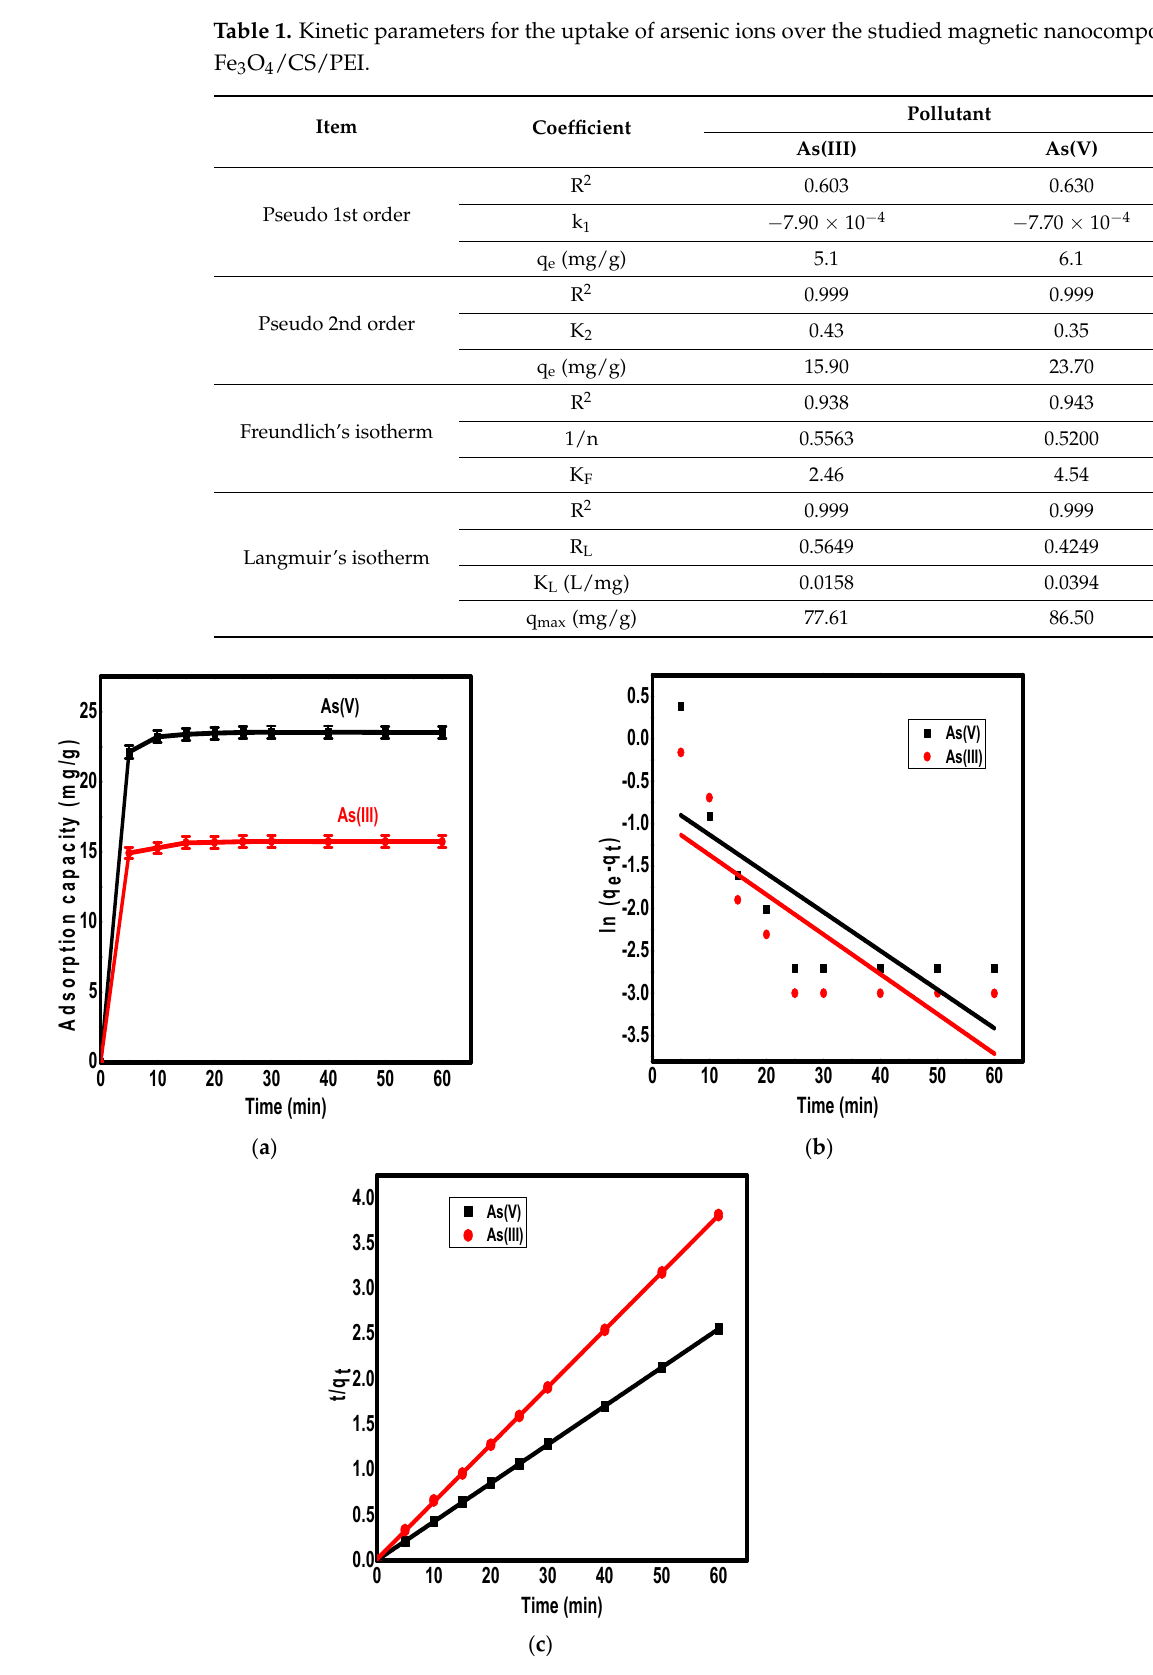
Figure 6. The contact time effect ( a ), pseudo first order plot ( b ), and pseudo second order plot ( c ) for the adsorption of As (III) and As(V) ions over the surface of Fe 3 O 4 /CS/PEI nanocomposite.